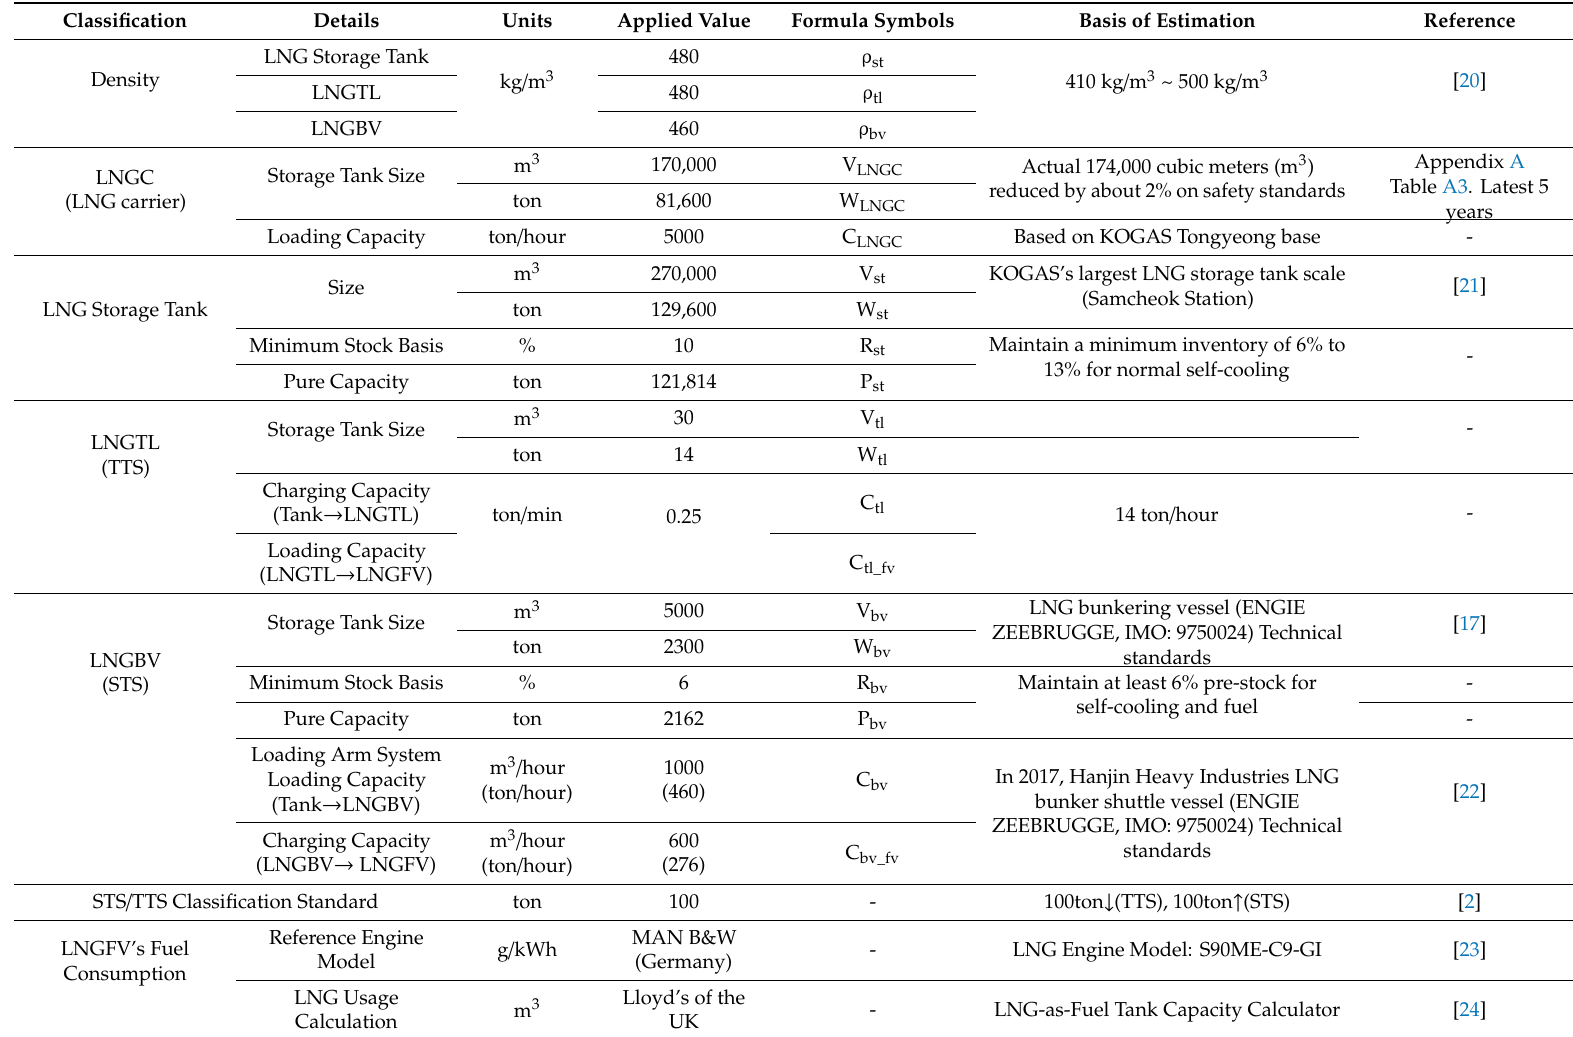
Table 4. Basic Assumptions for Estimating LNG Bunkering